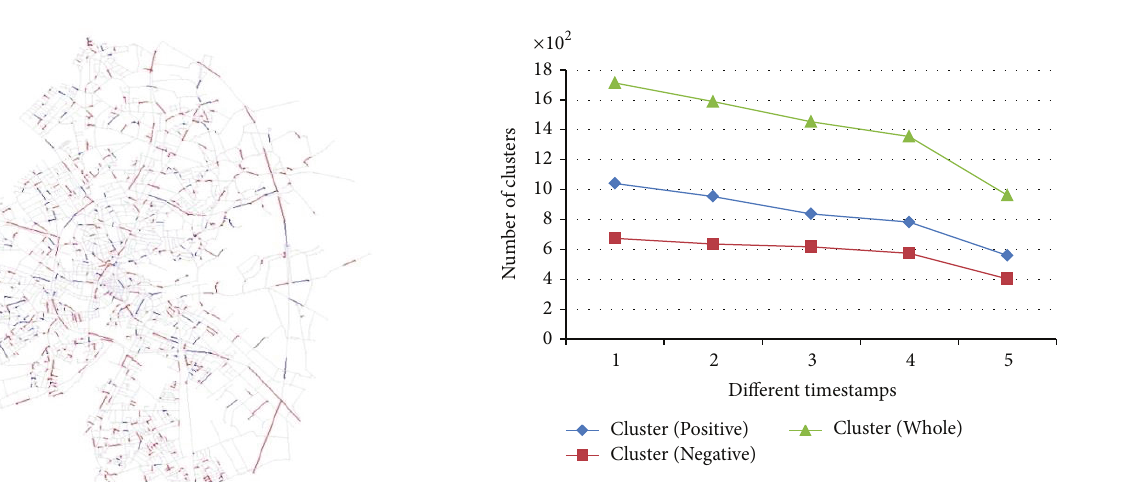
Figure 7: The number of congested routes according to the different timestamps. Table 1: The values of